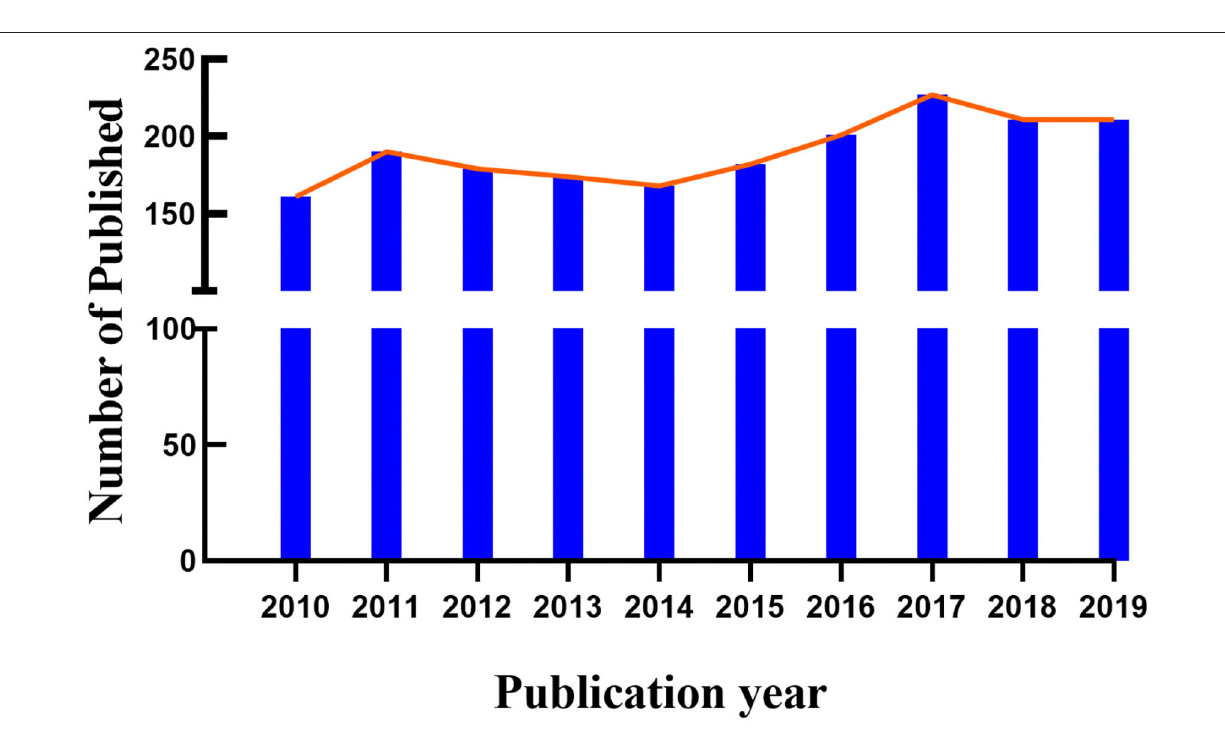
Frontiers in Genetics |